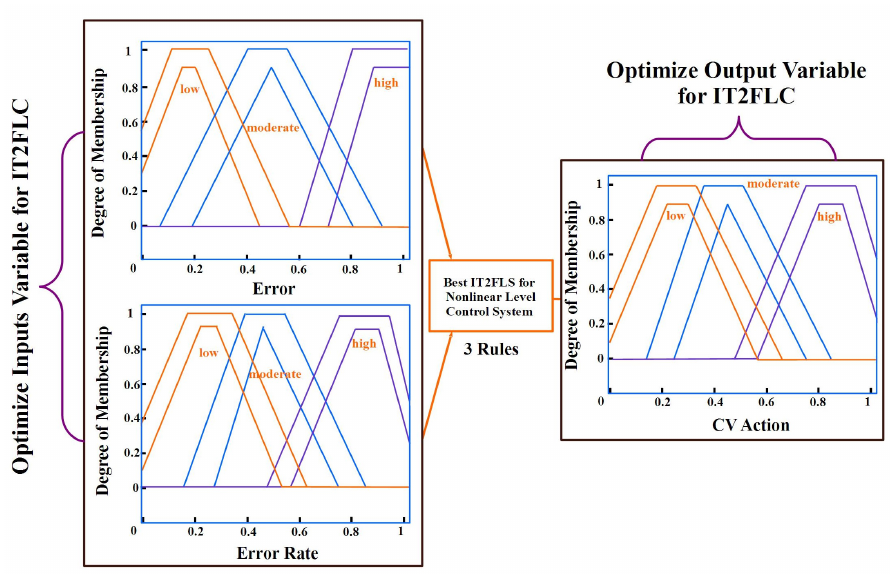
Figure 11. Best/Optimize IT2FLS that CS algorithm using ST2FIS finds for the frustum two-tank fuzzy Controller.